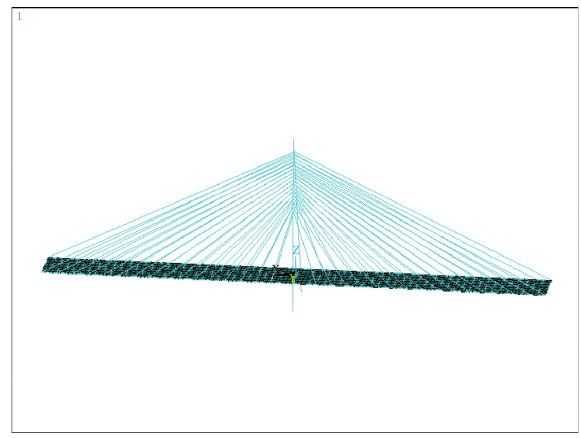
Figure 3: Cable-stayed bridge model.